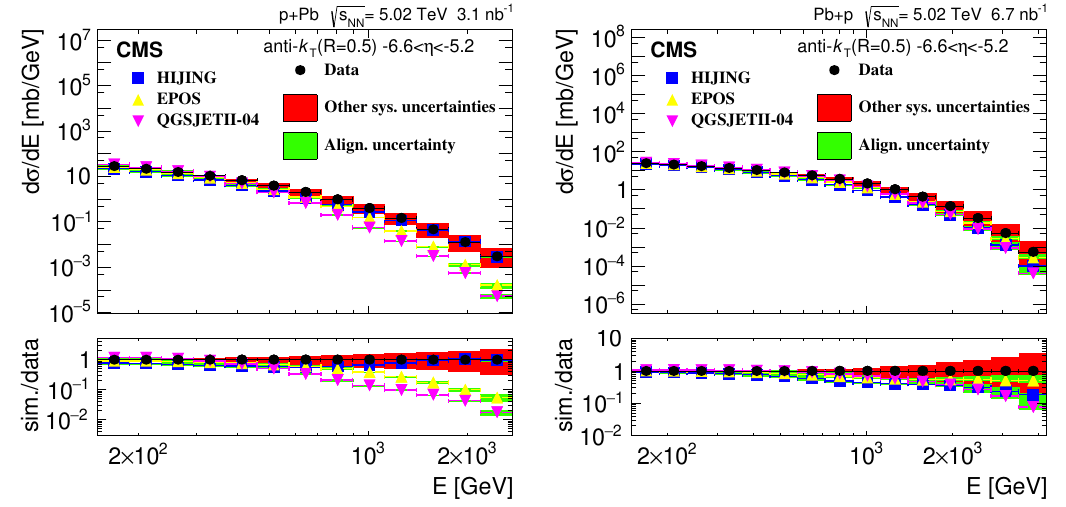
Figure 2 . Detector-level di(cid:11)erential cross sections for inclusive forward jet production as a function of calibrated jet energy in p+Pb (left) and Pb+p (right) collisions. Model predictions are shown for epos-lhc , hijing , and qgsjetii-04